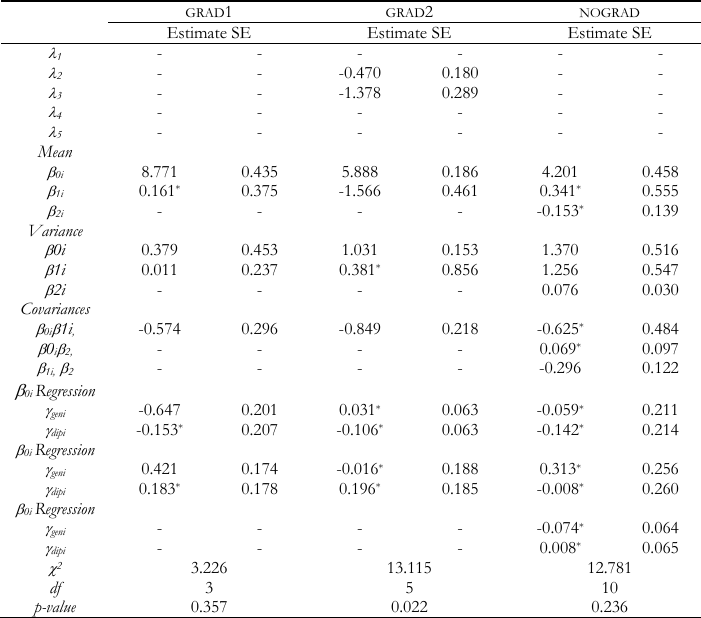
Parameter estimation for the conditional models, GRAD1, GRAD2, NOGRAD GRAD 1 GRAD 2 Estimate